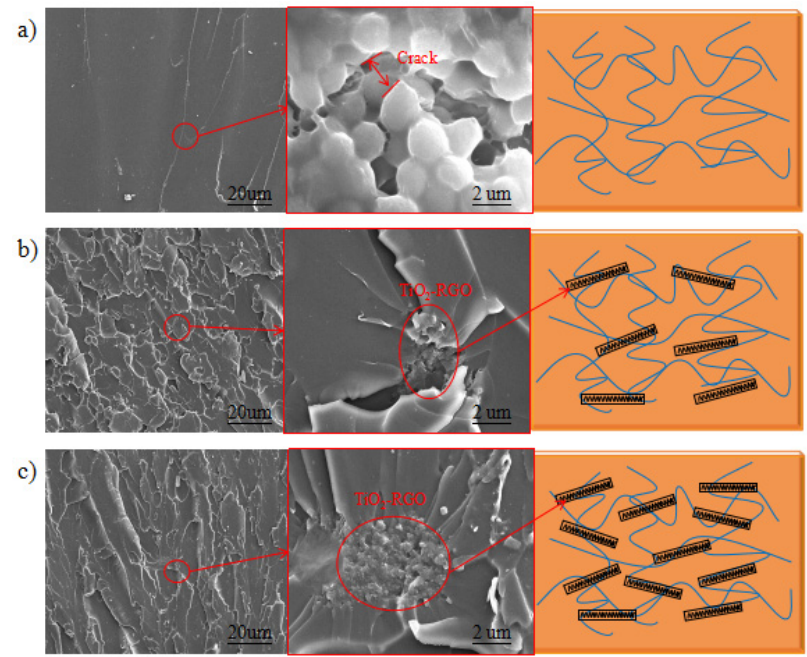
Figure 9. SEM images of the break section of TiO 2 -RGO-EP composites with different dosage of TiO 2 -RGO nanocomposites. ( a ) 0%, ( b ) 0.03%, ( c ) 0.10%.